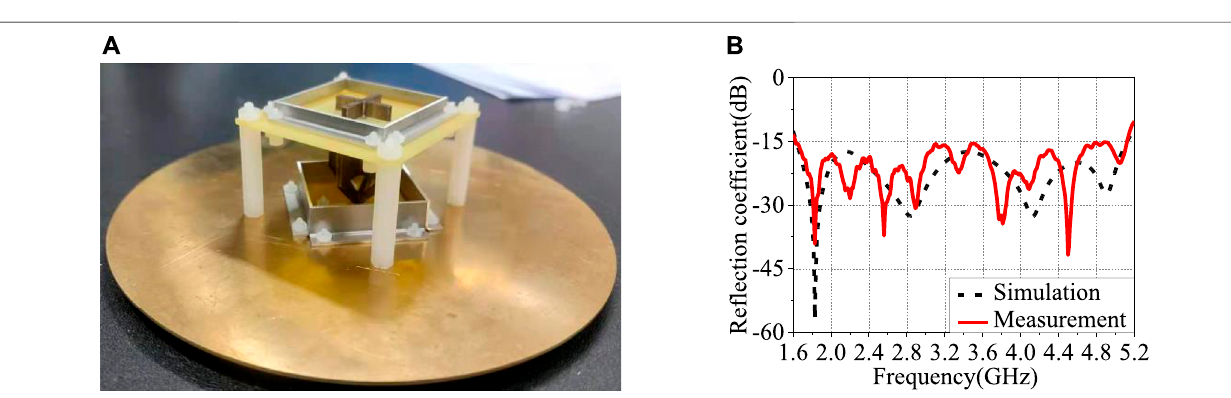
Frontiers in Physics |